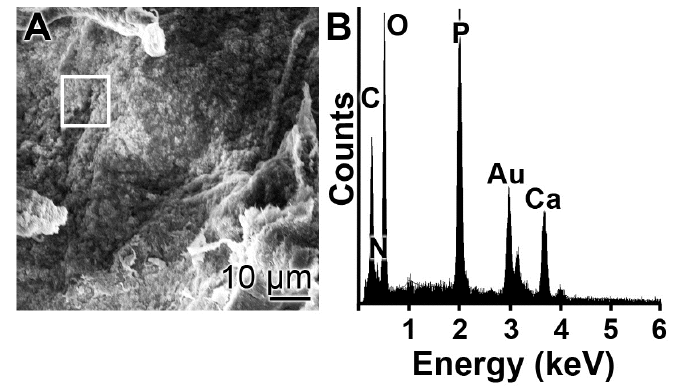
Figure 5. Energy-dispersive X-ray (EDX) analysis of “col/polyP-MP”. ( A ) SEM analysis and ( B ) EDX spectrum. The prominent element peaks (C, N, O, P and Ca) are marked. The Au peak originates from the gold surface after sputtering. The white square in ( A ) delimits the area selected for the EDX analysis.